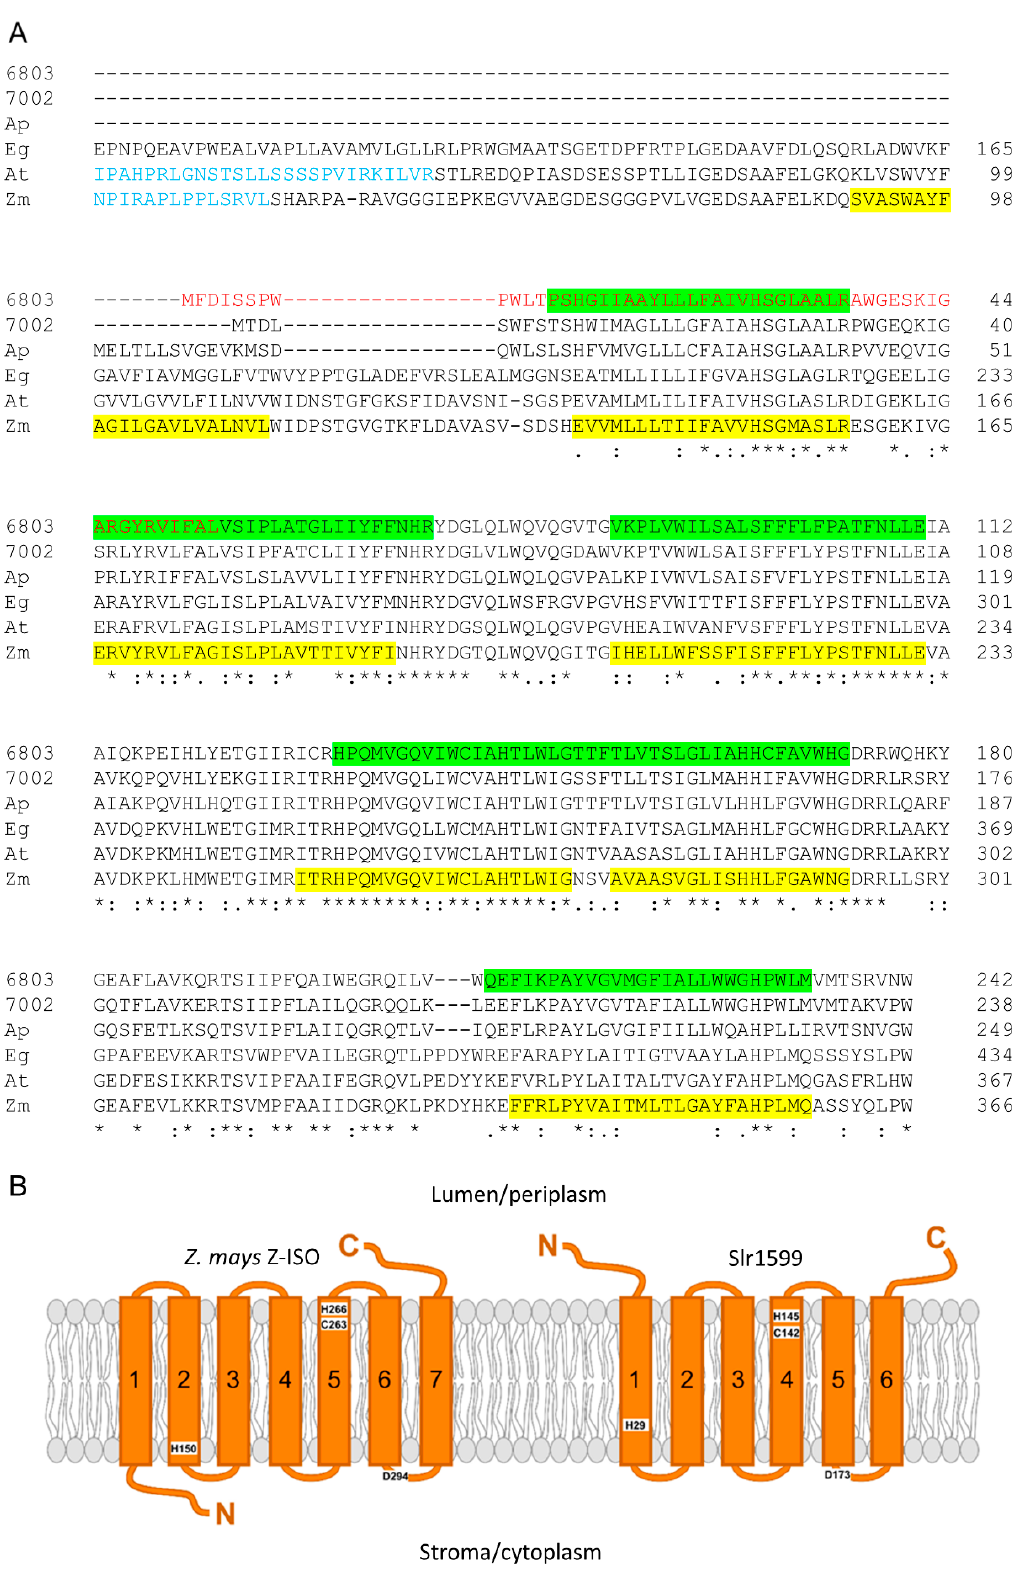
Figure 2. Sequence alignment of Slr1599 with known Z-ISO enzymes from other oxygenic pho- totrophs. ( A ) Sequence alignment of Slr1599 (6803) with Z-ISO homologs from Synechococcus 7002 (7002), A. platensis (Ap), E. gracilis (Eg), A. thaliana (At), and Z. mays (Zm). The N-terminal sequence in Slr1599 that is ‘missing’ in some databases is indicated in red font. Note that the eukaryotic